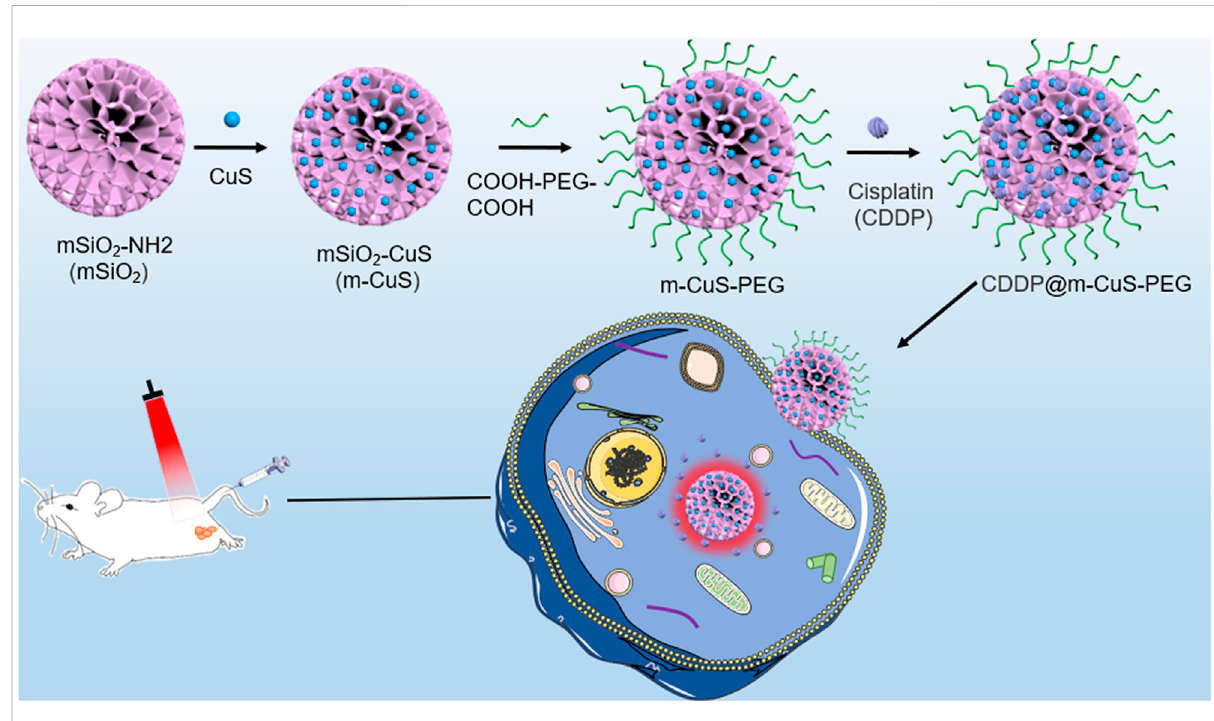
FIGURE 1 Schematic illustration of the synthesis process of CDDP@m-CuS-PEG NPs and the bone targeting delivery system, CDDP@m-CuS-PEG NPs.